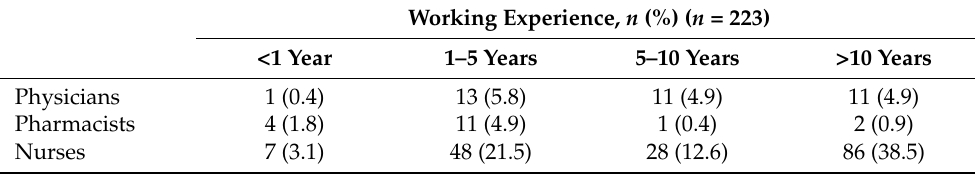
Table 3. Working experience of study participants.